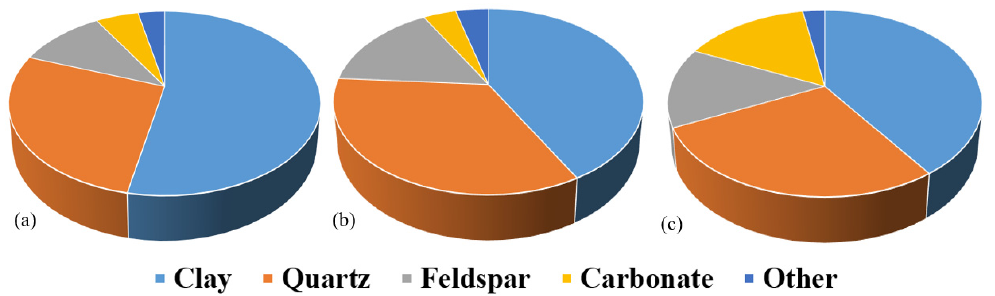
Figure 5. Average mineral composition of shale samples: ( a ) foliaceous shale; ( b ) laminated feisic shale; and ( c ) laminated diamictic shale.